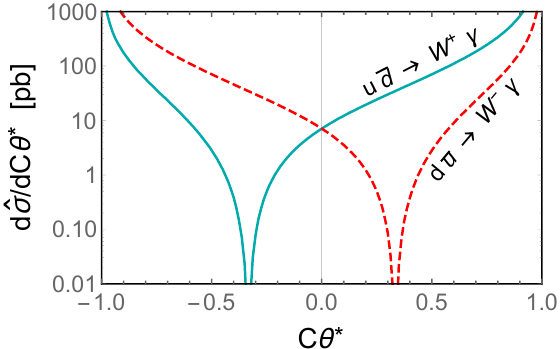
Figure 2 . Partonic angular distribution for W (cid:6) (cid:13) production. The RAZ is located at cos (cid:18) (cid:3) = (cid:7) 1 = 3, where (cid:18) (cid:3) is the angle between the incoming quark and the photon in the CM